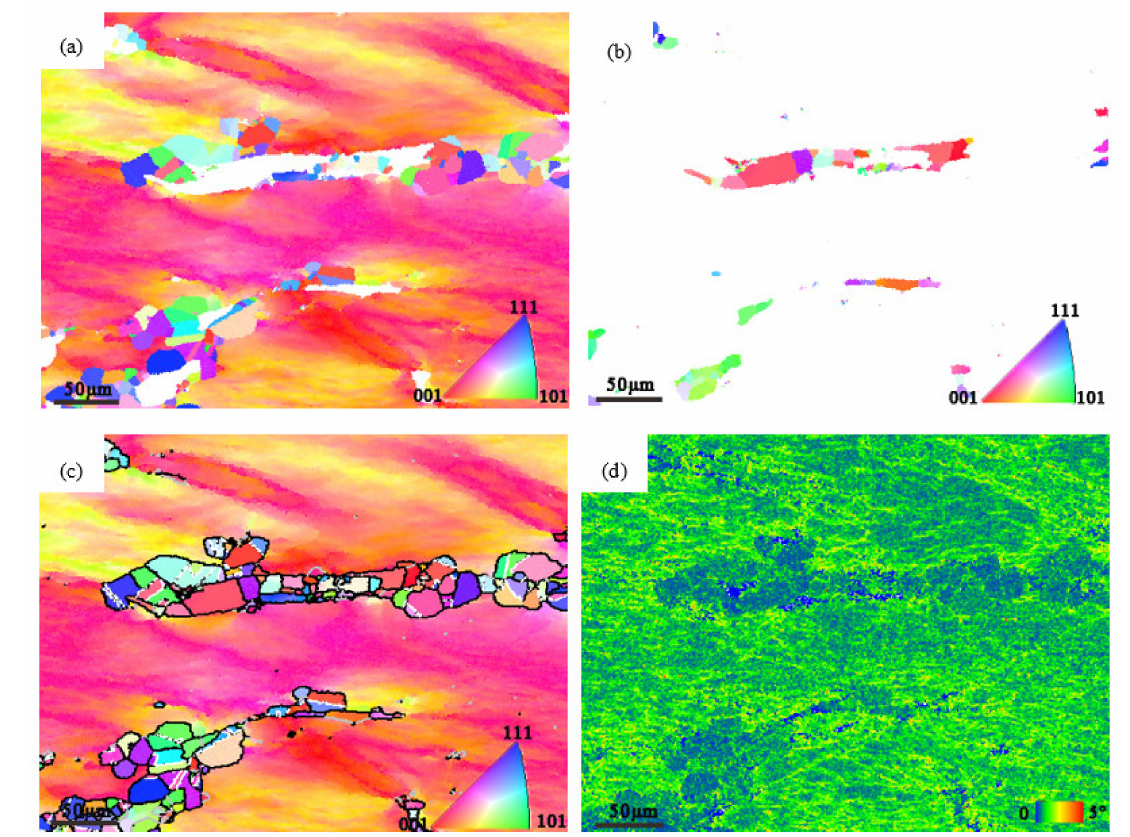
Figure 13. IPF map and KAM map under 1100 ◦ C, 1 s − 1 conditions: ( a ) IPF map of austenitic; ( b ) IPF map of δ ; ( c ) IPF map and grain boundary; ( d ) Corresponding KAM